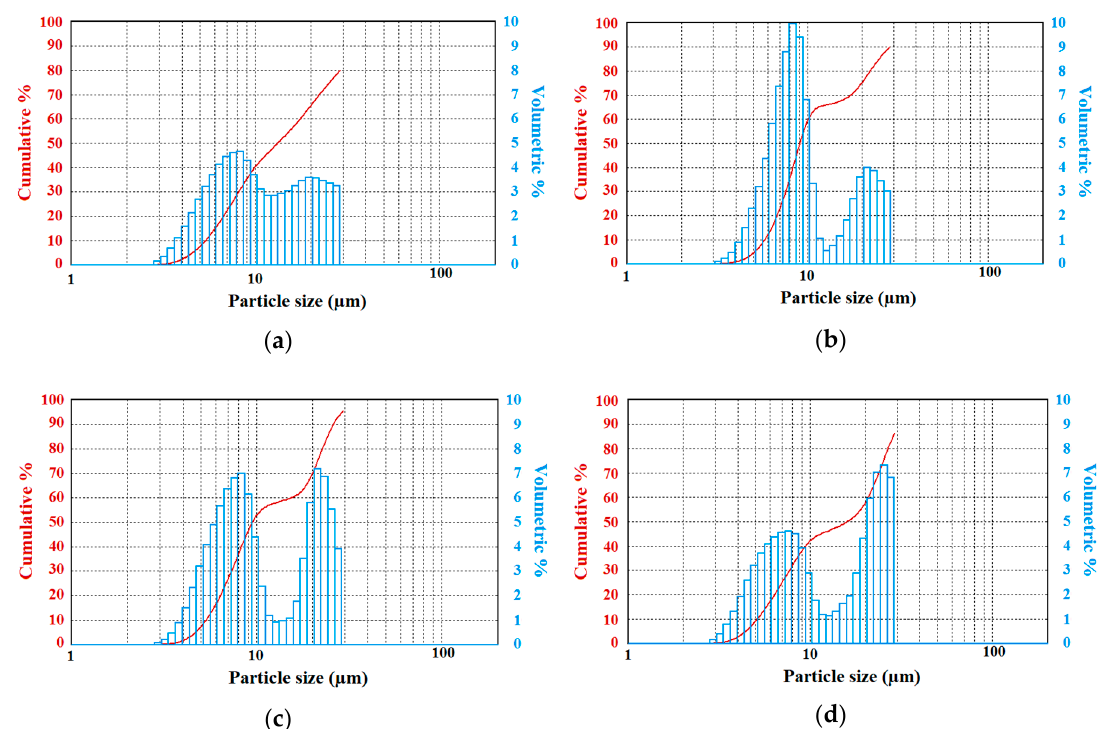
Figure 2. The % of solution contribution to fog spectral volume (right y -axis) and cumulative particle volume concentration (left y -axis) versus droplet diameter ( x -axis) are shown similarly in ( a ), ( b ), ( c ), and ( d ). Averaged fog droplet spectra below 30 µ m containing 2.5%, 5%, 7.5%, and 10% of the amounts of dissolved urea (carbamide) are shown in ( a ), ( b ), ( c ), and ( d ), respectively.